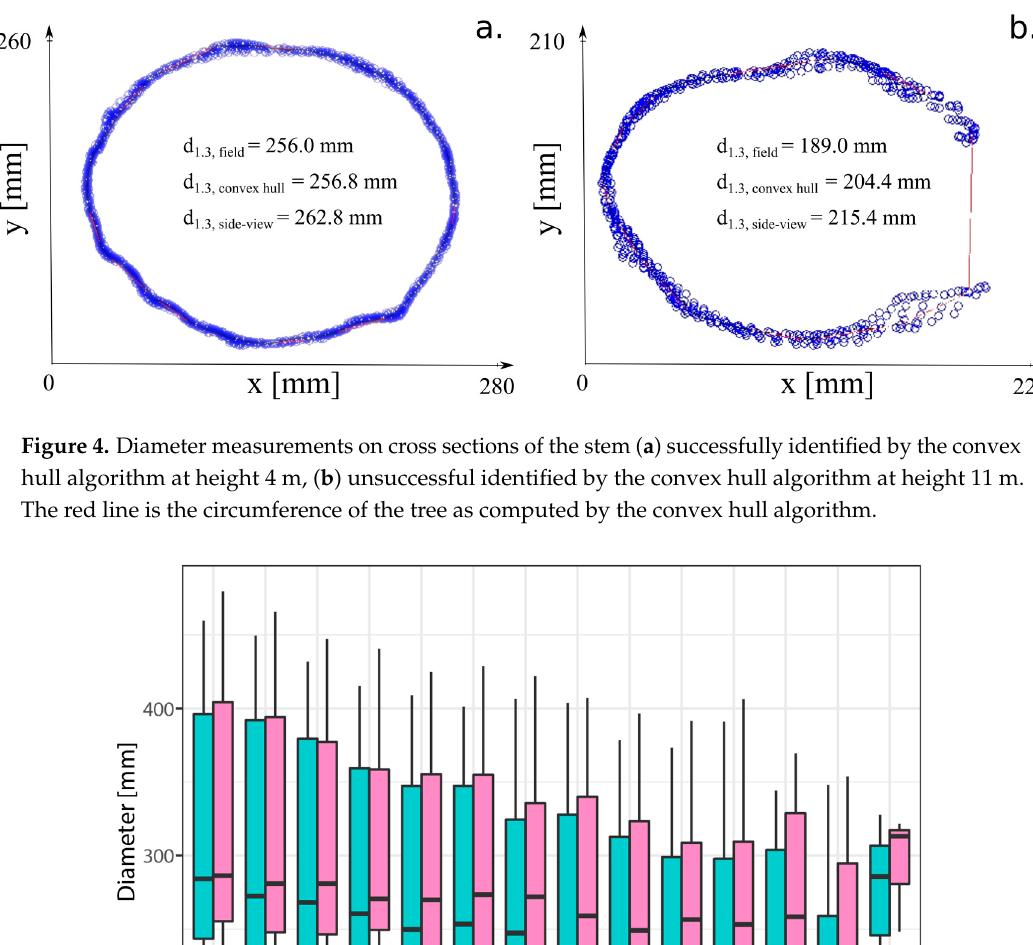
Figure 4. Diameter measurements on cross sections of the stem ( a ) successfully identified by the convex hull algorithm at height 4 m, ( b ) unsuccessful identified by the convex hull algorithm at height 11 m. The red line is the circumference of the tree as computed by the convex hull algorithm.